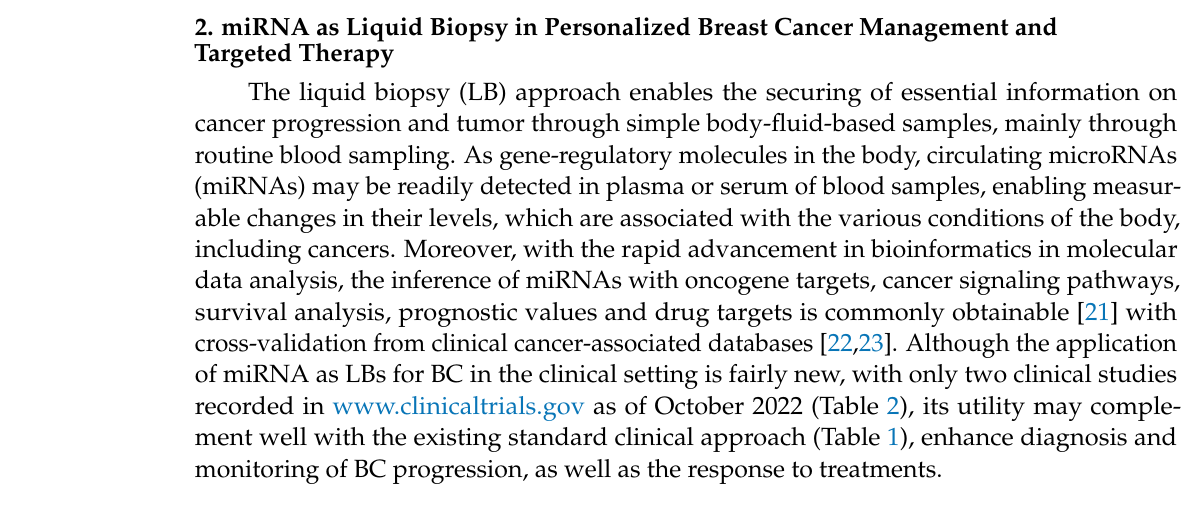
Table 2. Clinical trials that involved circulating miRNAs as liquid biopsy of human breast cancer (n =